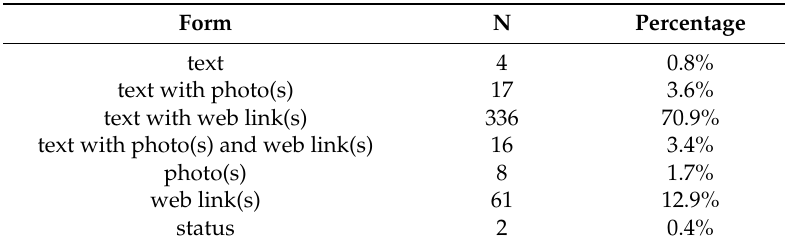
Table 3. The types and number of forms of 474 posts.